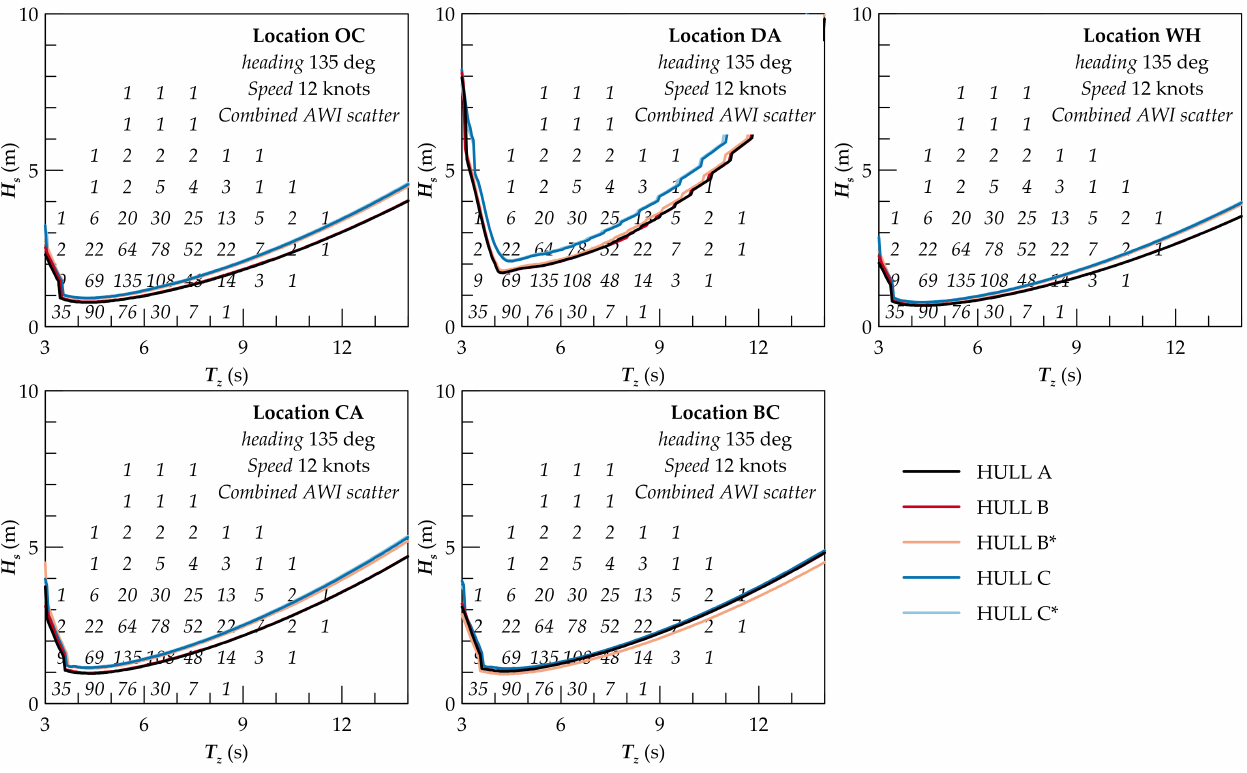
Figure 23. Limiting comfort criteria curves on the combined Area 27 and 47 scatter diagram for the AWI 22834 locations at 12